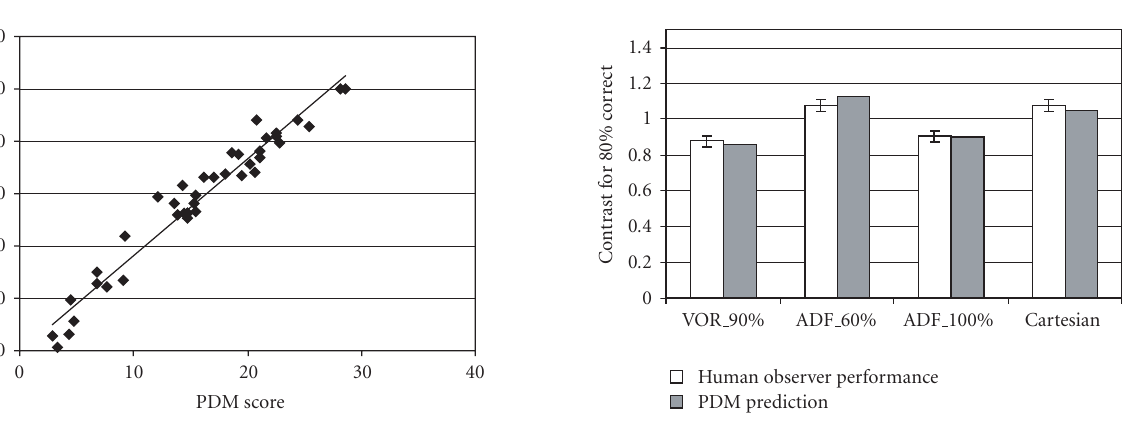
Figure 5: Comparison between human detection in the 4-AFC ex- periment and scaled PDM scores. PDM scores correlate surprisingly well with this task-oriented measure of image quality. We chose four interesting conditions that include the e ff ect of DCFs and sampling densities. Other parameters are conventional regridding, 5 inter- leaves, and noise = 3. The Cartesian case is added for comparison. Detailed conditions for experiments are described in Section